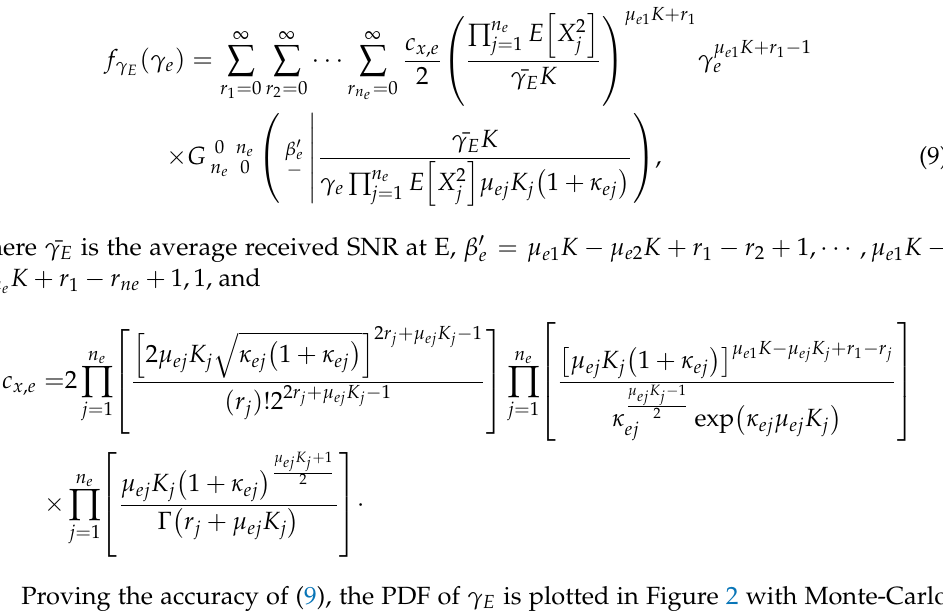
+ µ e 1 K e (cid:48) n e K